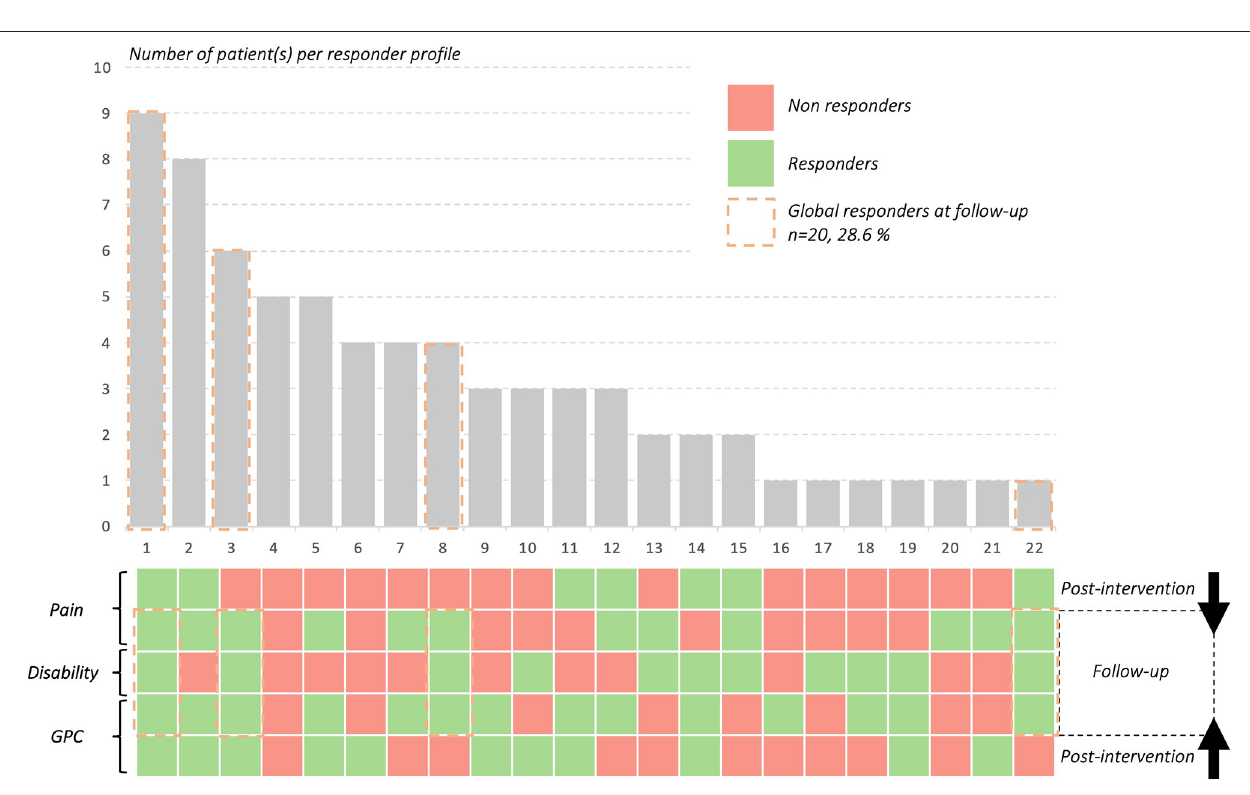
FIGURE 4 | Patients’ response profiles and proportions. Complete data on n = 70 patients with 22 patients’ response profiles observed. For example, 9 patients (profile 1) were responders at all time points for each outcome whereas 5 patients were non-responders at all time points for each outcome (profile 4). GPC = GLobal Perceived